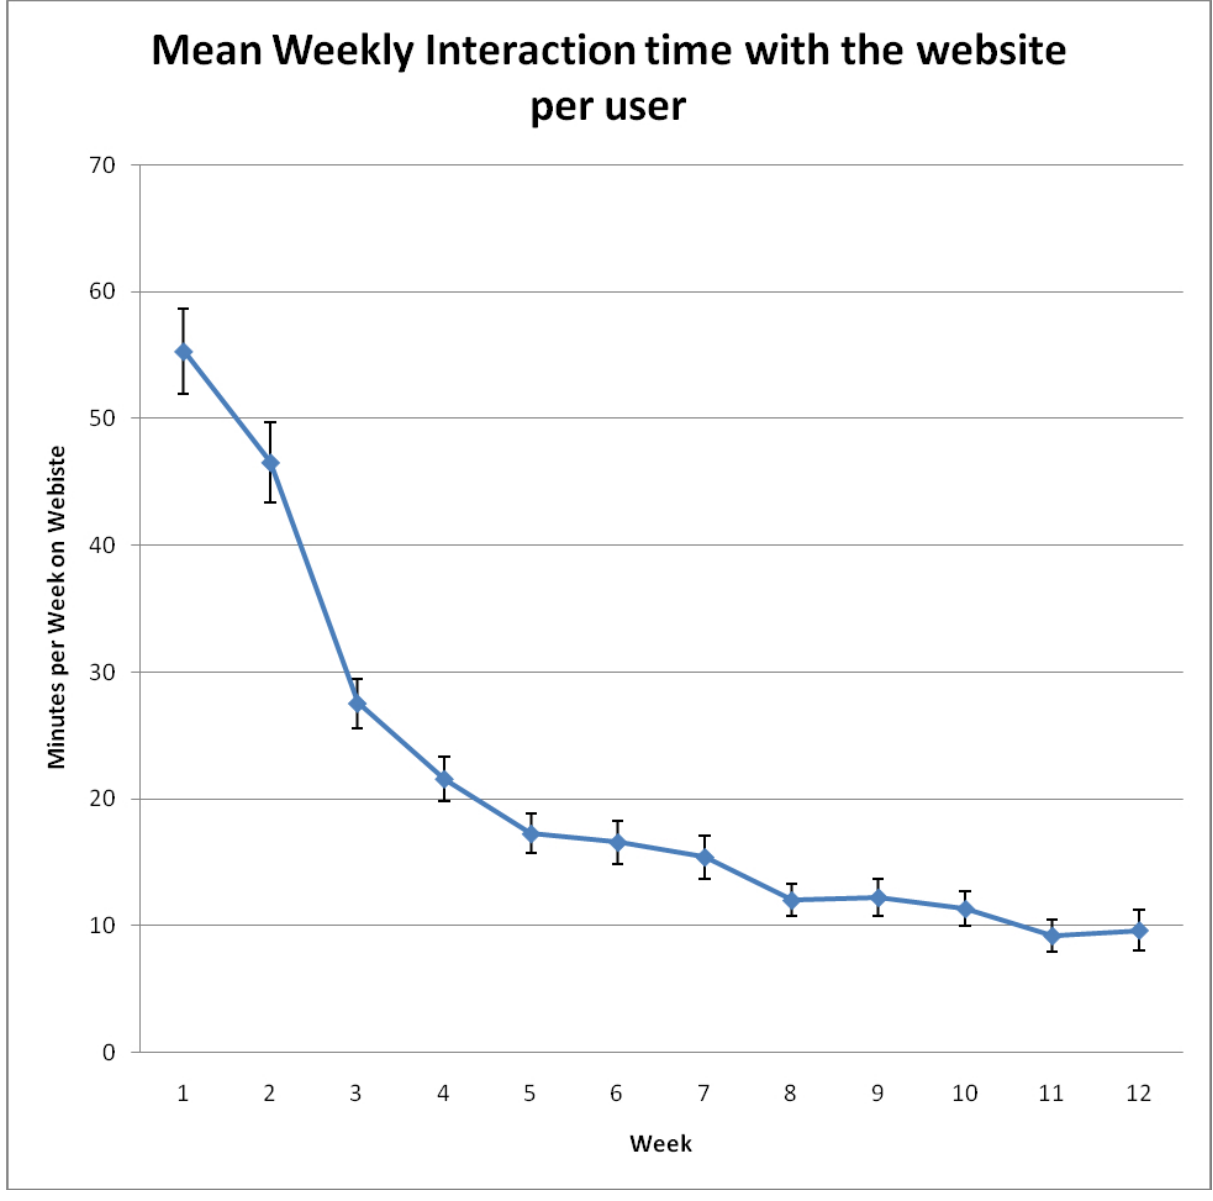
Figure 5. Mean interaction time with the website throughout the study period (Data points are means with standard error and are presented for all employees as there was no significant difference between the sites based on